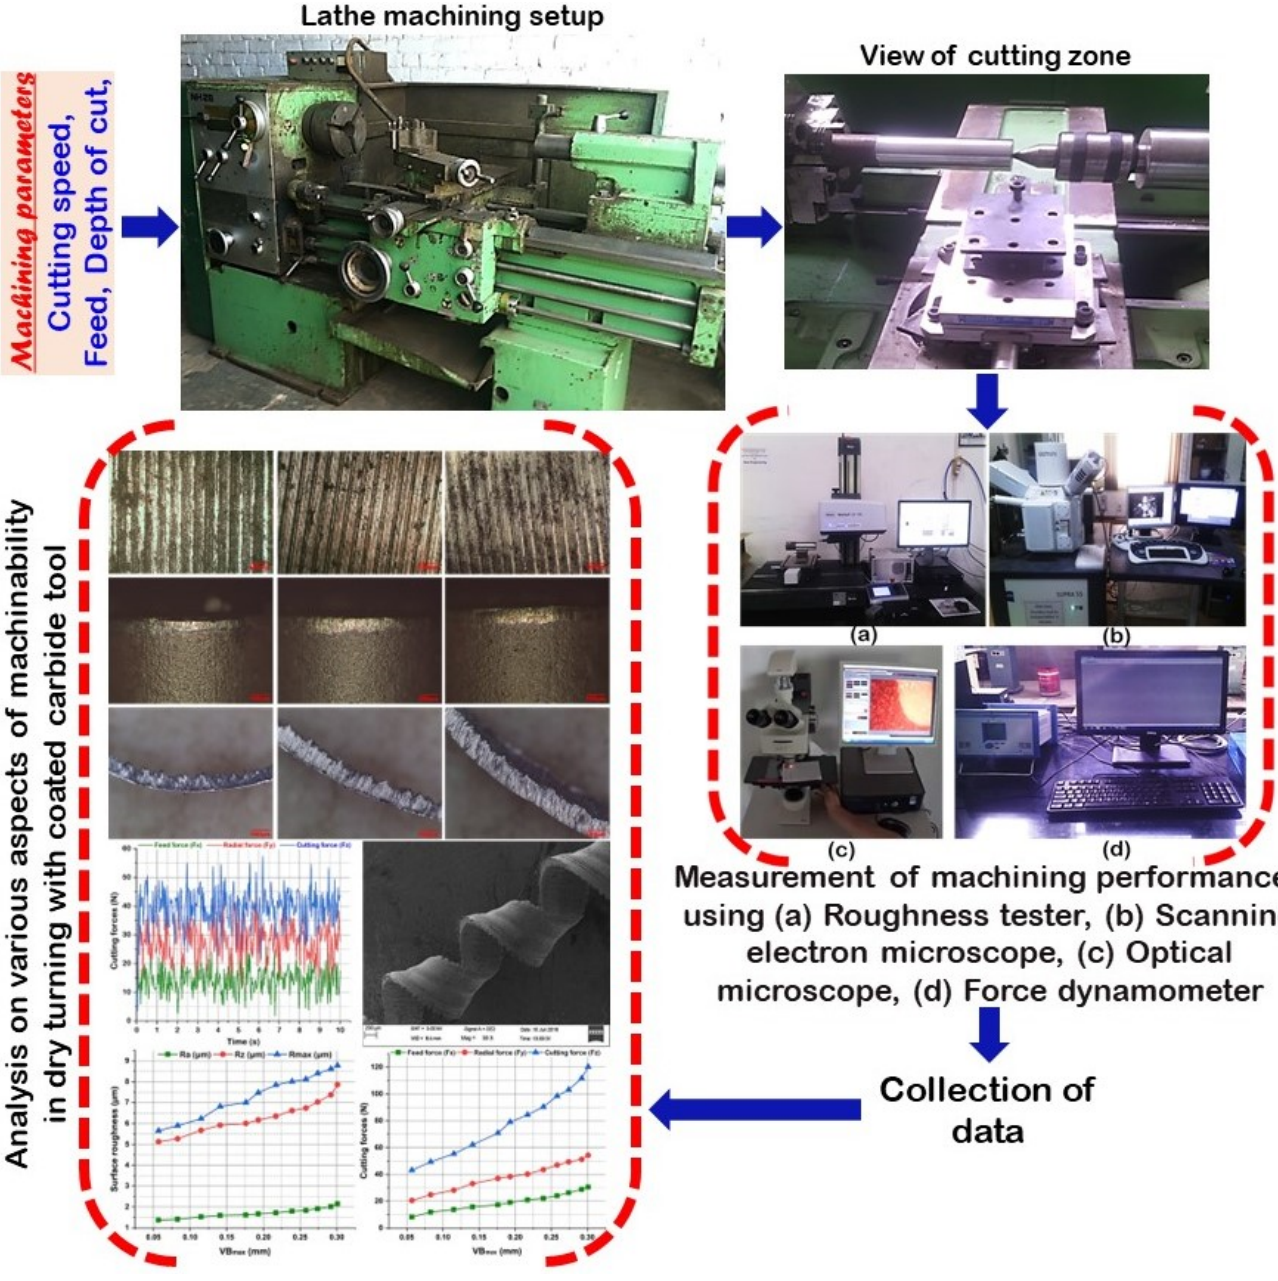
Figure 3. The layout of the experimental setup and procedure.